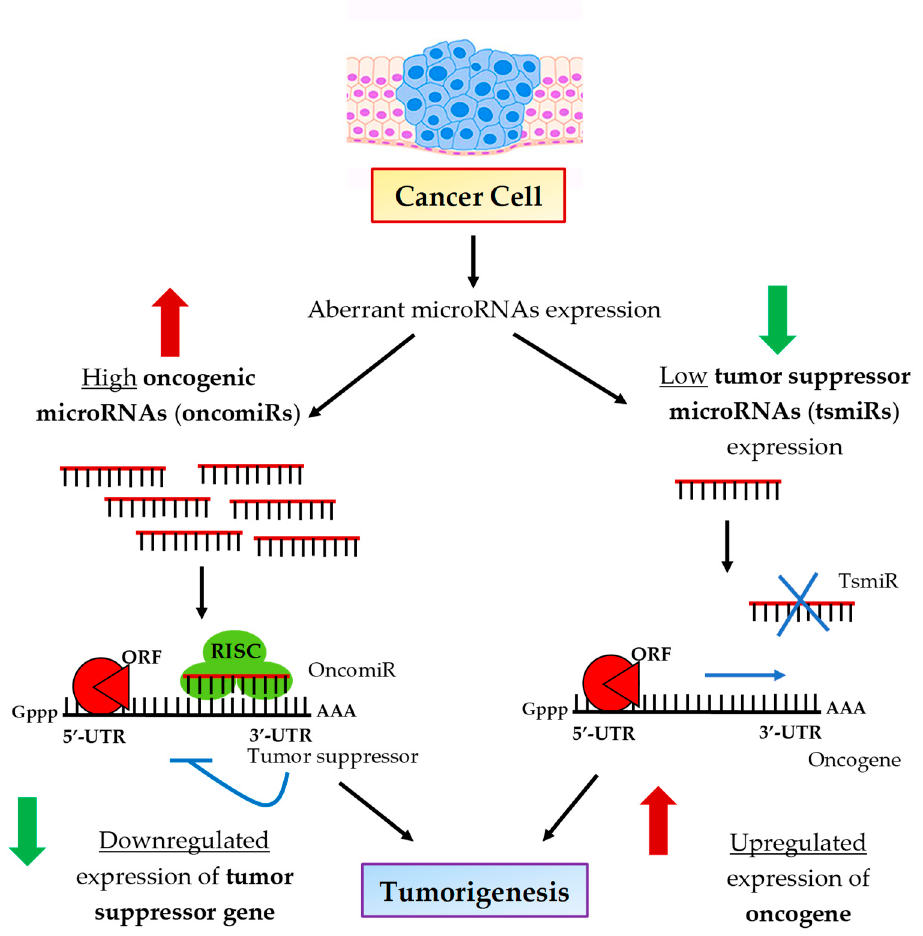
Figure 2. Regulatory mechanisms of oncogenic and tumor suppressor microRNAs in tumorigenic events. Increased expression of oncogenic miRNAs in cancerous cells inhibits tumor suppressor genes. Decreased expression of tumor suppressor miRNAs potentially enhances the expression of oncogenes. Consequently, both oncogenic and tumor suppressor miRNAs lead to tumor development by stimulating cell proliferation, anti-apoptotic response, replicative immortality, invasion, metastasis and angiogenesis. Reproduced with permission from Joshi, M.; Singh Sodhi, K.; Pandey, R.; Singh, J.; Goyal, S.; Dahal, A. MicroRNA: Biomarker for cancer diagnosis and prognosis. J. Pharm. Biomed. Sci. 2014 [55].